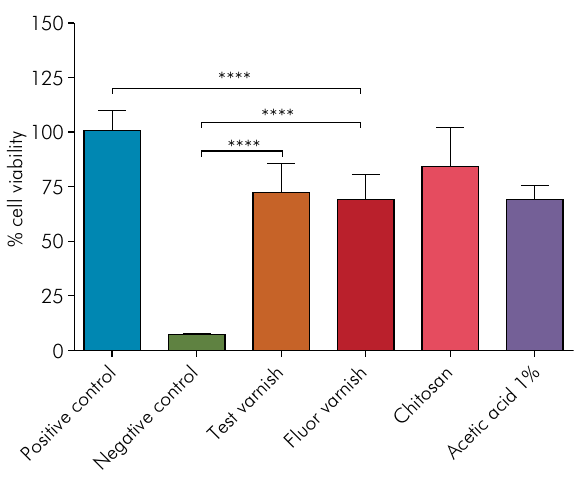
Figure 2. MTT-based viability assay of fibroblast culture after 48 hours in contact with the following materials: positive control (culture medium+cells); negative control (culture medium); test varnish (propolis varnish); fluoride-containing varnish (gold standard, Duraphat ® ); vehicle control (chitosan varnish); and 1% acetic acid. Four asterisks (****) indicate significant differences among the groups at p < 0.0001 (One-way ANOVA with Tukey-Kramer HSD).